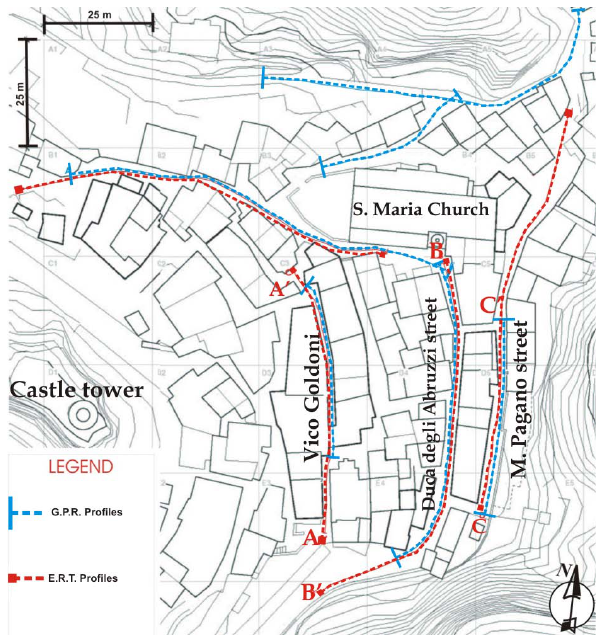
Fig. 6. Map of geophysical investigations carried out in historical centre of Rabatana